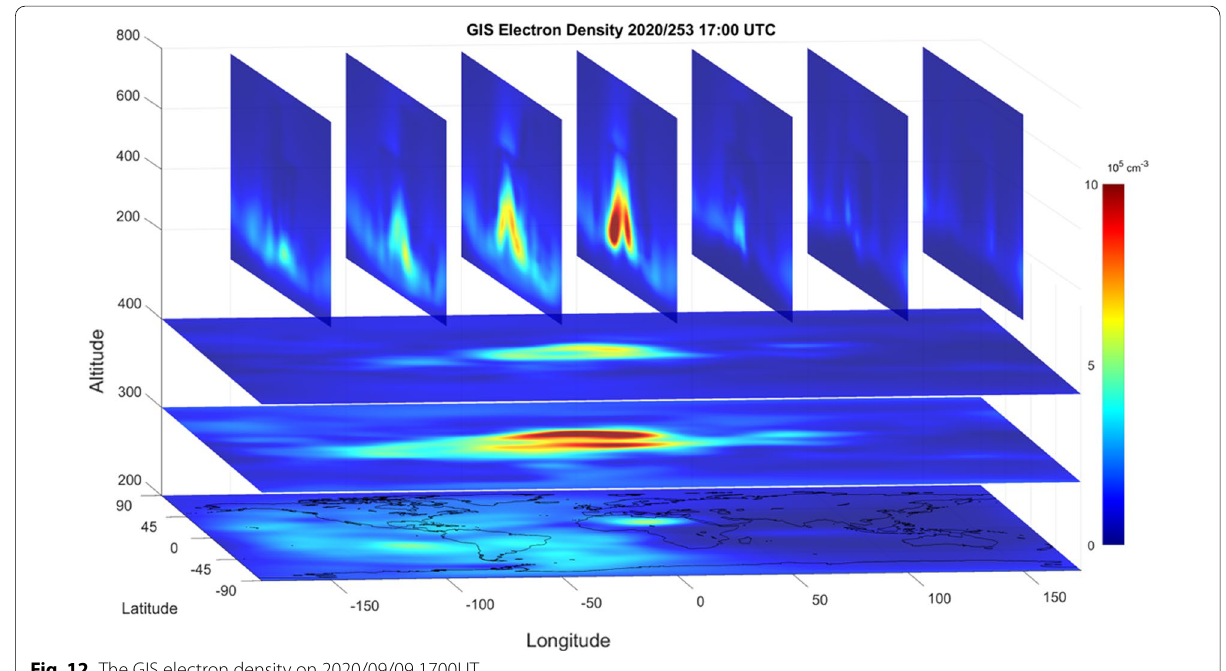
Fig. 12 The GIS electron density on 2020/09/09 1700UT